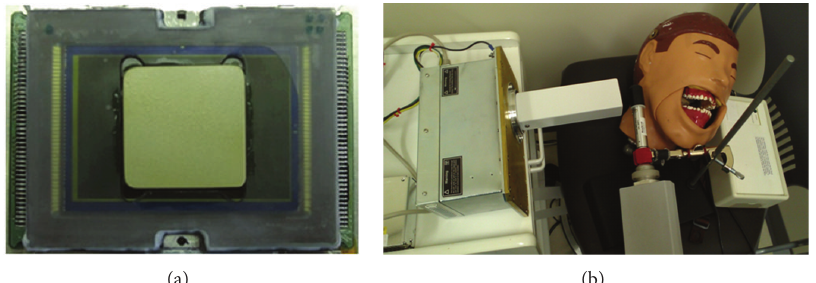
Figure 3: (a) Dental size sensor with microlens coupled with scintillator/FOP (front view) and (b) LDXI prototype testing on the DXTTR phantom at 0.2 mA and 80 kVp.